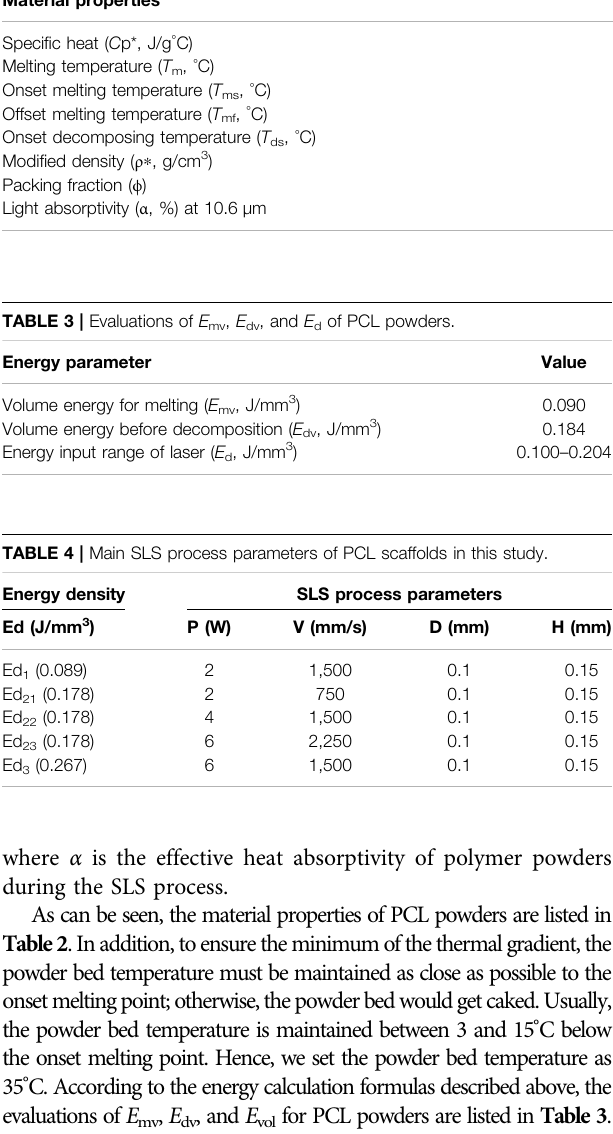
TABLE 2 | Material properties of PCL powders. Material properties